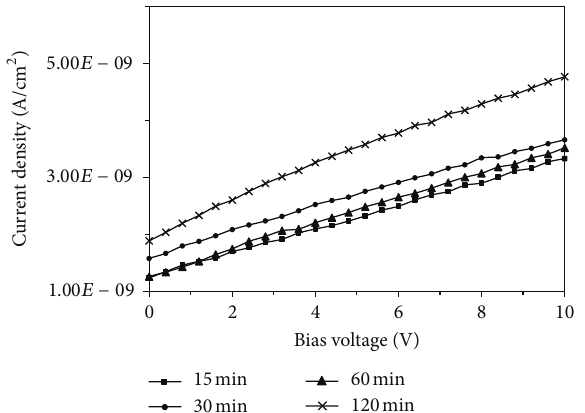
Figure 5: Leakage current densities of the induced poly-Si thin films annealed under four different annealing time